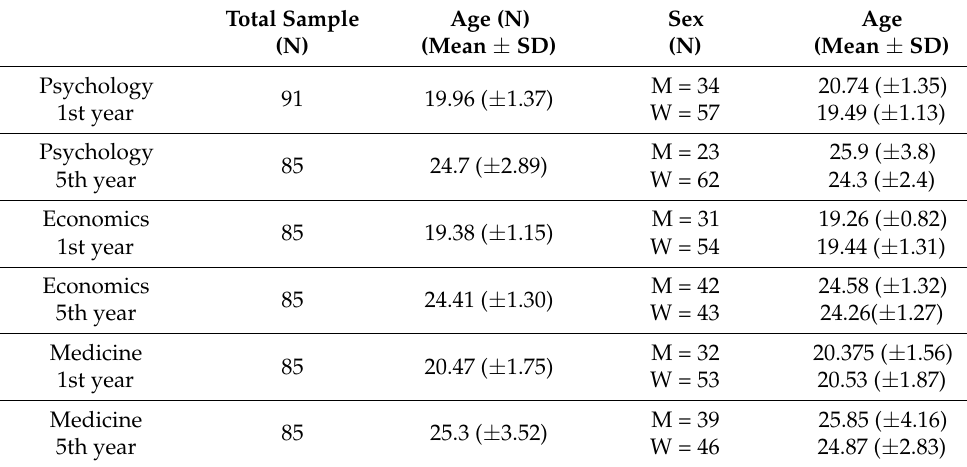
Table 1. Demographic information on the investigated sample (mean ± standard